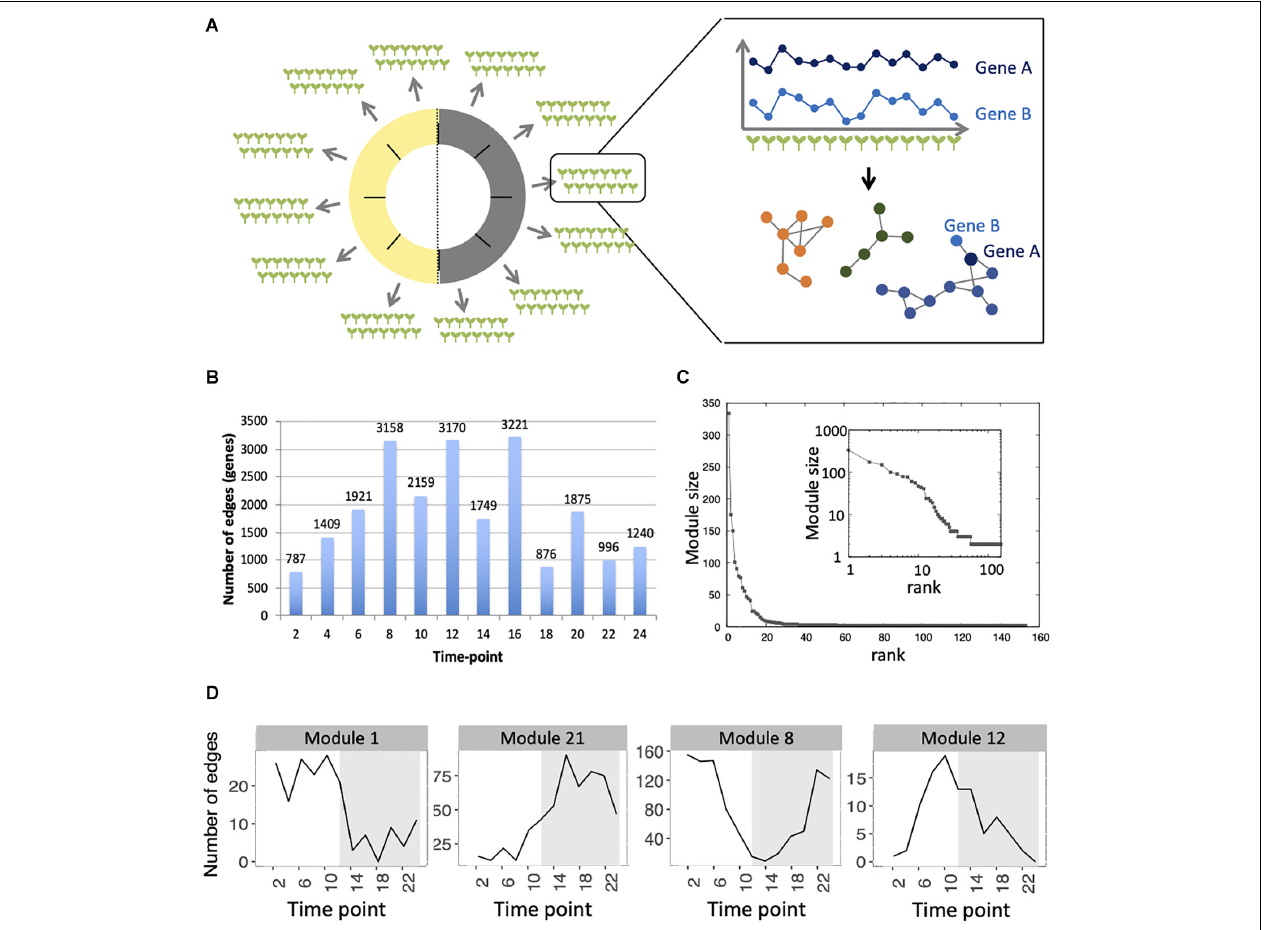
FIGURE 1 | Inference of gene co-expression networks in absence of genetic and environmental perturbations. (A) Description of co-expression network inference using transcriptomes performed on single seedlings. Transcriptomes were generated for a total of 14 seedlings per time point, with 12 time points spanning a day/night cycle over 24 h. In each time point, genes with correlated expression profiles in the 14 seedlings were identified. The co-expression network was inferred based on pairs of genes significantly correlated in at least four consecutive time points. Finally, modules in the network, which consist of groups of genes that are densely connected, were detected. (B) Total number of edges in the final network that are detected in each time point. (C) Distribution of the number of genes present in each of the 153 modules. Inset shows the same data plotted with a logarithmic scale. (D) Number of edges that are detected in each time point for four modules: module 1 in which most edges are detected during day time, module 21 in which most edges are detected during the night time, module 8 in which most edges are detected at the transition between night and day, and module 12 in which most edges are detected at the transition between day and night.